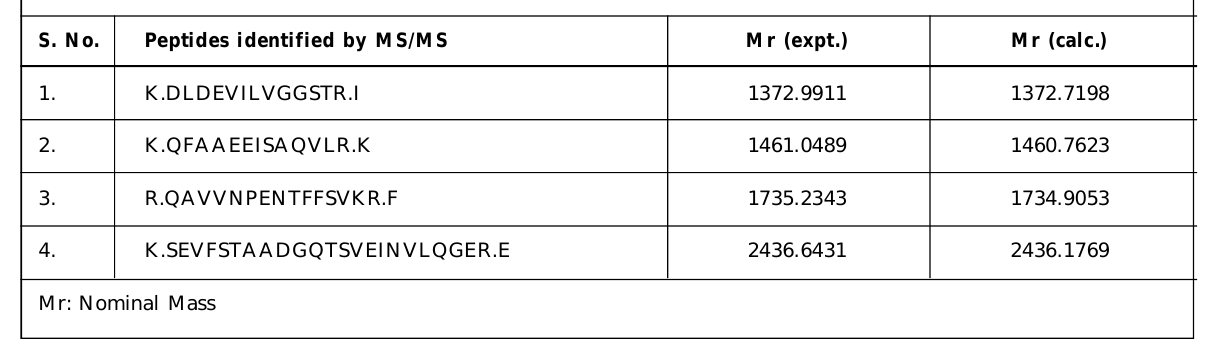
Table 4C: The MALDI TOF mass spectrum sequence of peptides matched with gi|302786294 hypothetical protein VITISV_000728 of Vitis vinifera (Protein score: 118) S. No.